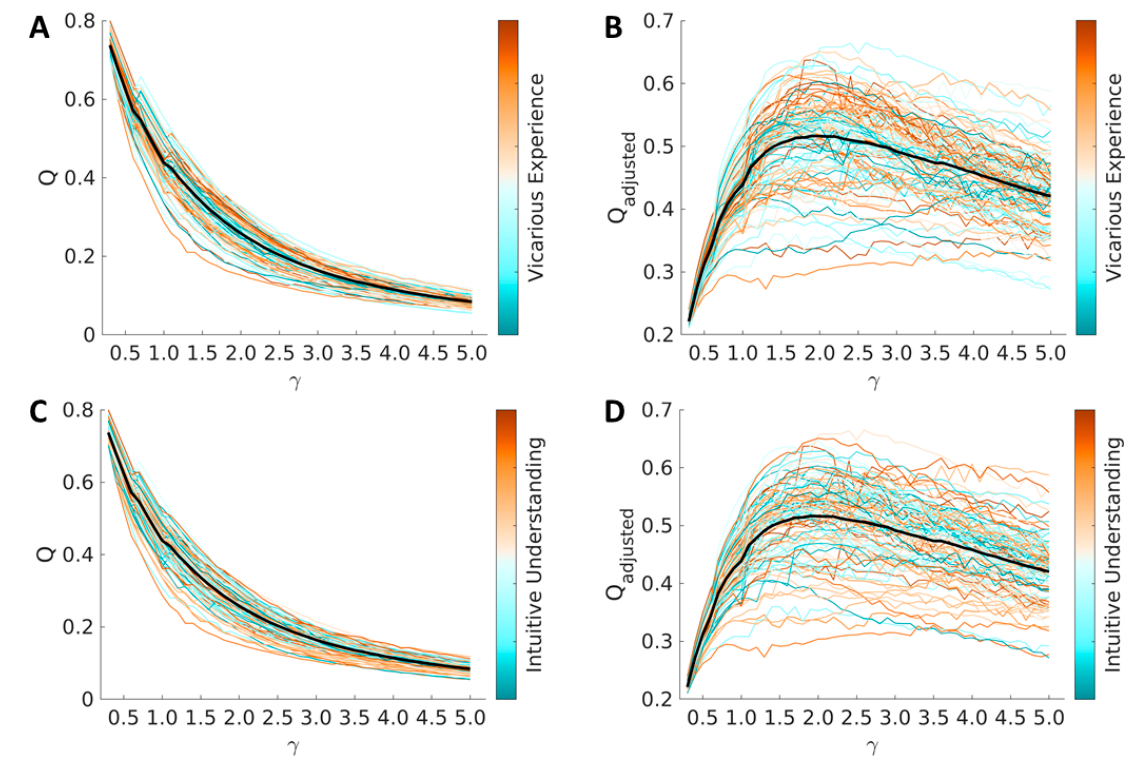
Figure 2. Modularity ( A , C ) and adjusted modularity ( B , D ) are represented both with average values (thick black line) and with single-subject values (thin colored lines). In ( A , B ), increased values of vicarious understanding are represented with more intense green colors. In ( C , D ), increased values of intuitive understanding are represented with more intense purple colors. As the figures show, and as described in the main text, modularity was not associated with vicarious experience or intuitive understanding.